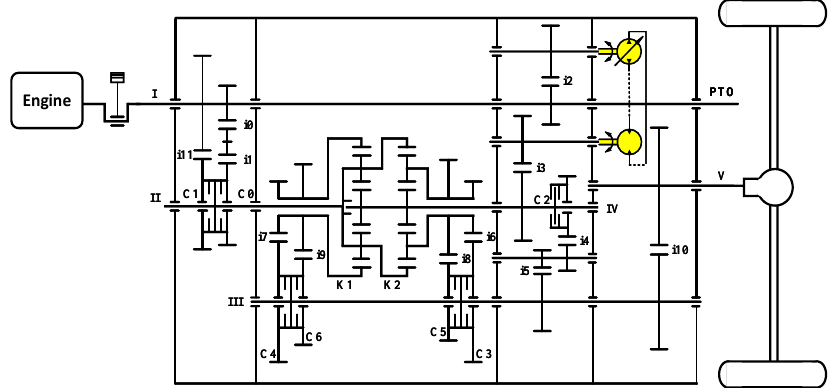
Figure 5. Schematic diagram of HMCVT transmission.